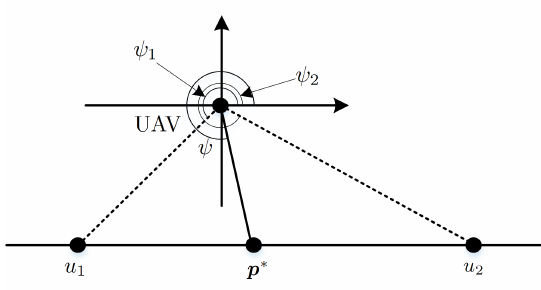
Figure 5. Bounded optimal heading in end-to-end communication.